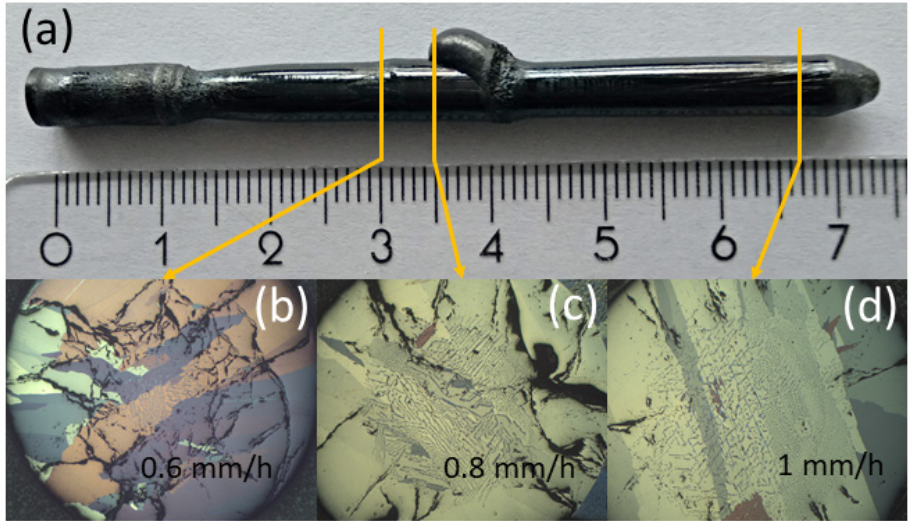
Figure 3. ( a ) Photo of the crystal with general composition La 1.51 Sr 0.19 Eu 0.3 CuO 4 , grown with different growth rates; ( b – d ) polarized microscopy photography of single crystal cross-sections, respective to a different growth rates, applied during the growth run.